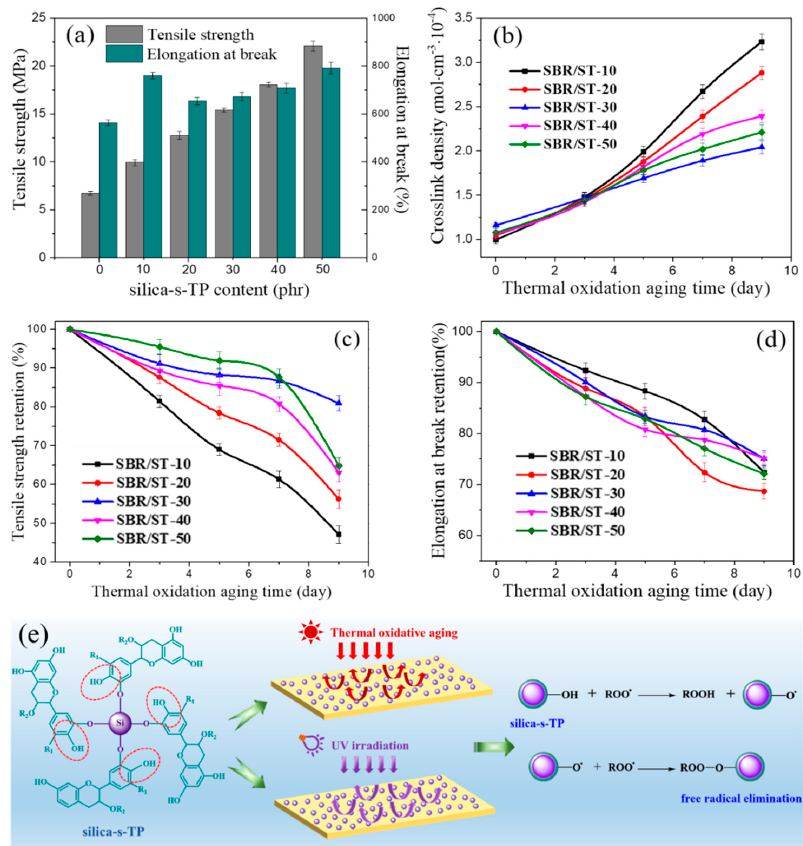
Figure 6 . ( a ) The mechanical properties of SBR/silica-s-TP composites; ( b ) the crosslink density, ( c , d